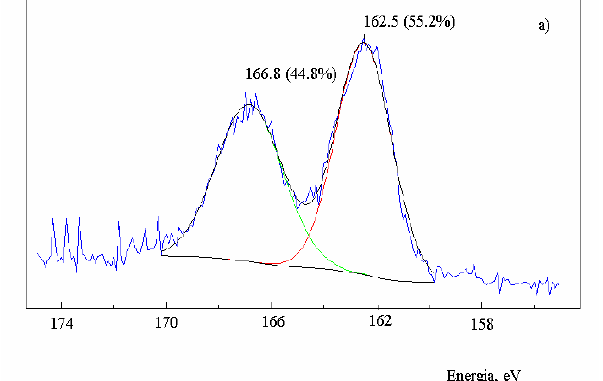
Figure 2 . XPS spectra in the S 630 o C and extraction with CS flow 95 mL·min -1 ; P c) in the presence of Na